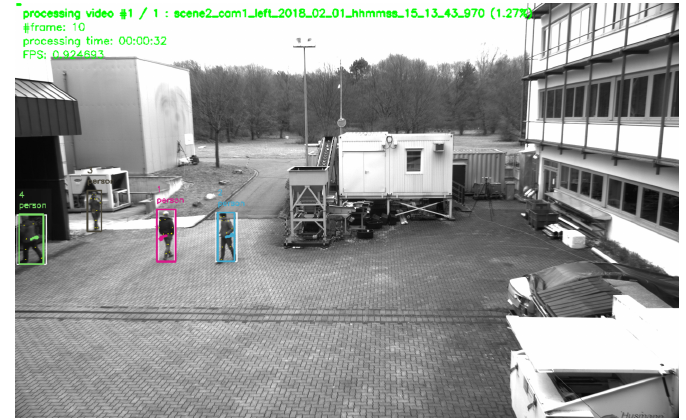
Figure 8. Frame taken from feature detection preprocessing procedure. During processing, the original video is played back while detected objects are